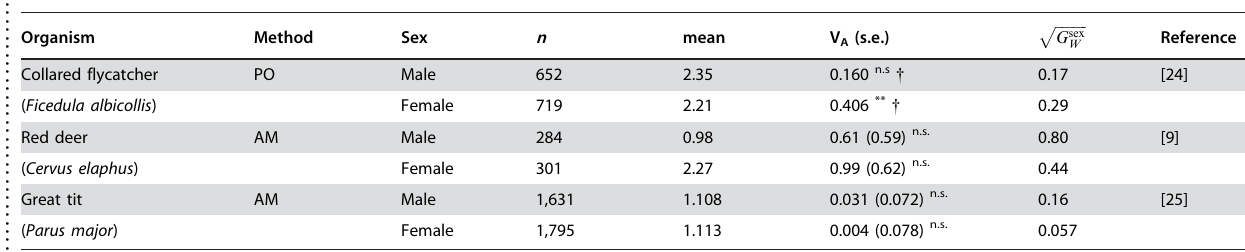
Table 1. Published estimates of additive genetic variance in estimates of lifetime fitness in wild populations. .. ... .... ... ... .... ... ... .... ... ... .... ... ... .... ... ... .... ... ... .... ... ... .... ... ... .... ... ... .... ... ... .... ... ... .... ... ... .... ... ... .... ... ...